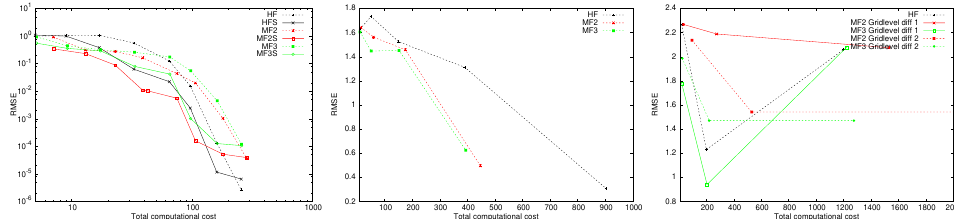
Figure 13. PCE: Rastrigin function RMSE (from left to right, two, five and ten dimensions). PCE and SPCE in dashed and solid lines, respectively.